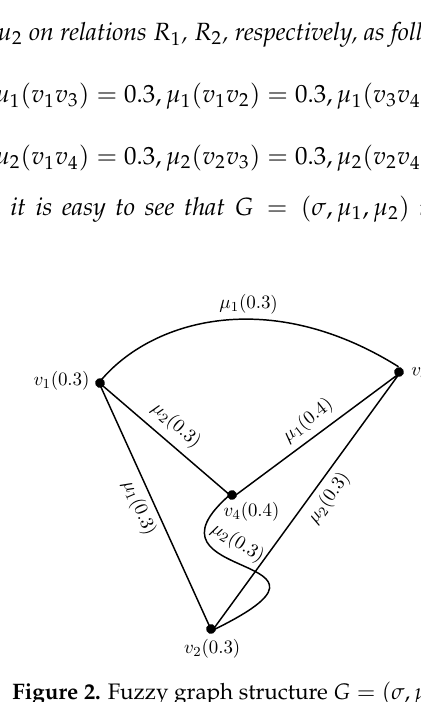
R 2 Figure 1: Graph Structure G ∗ = ( V, R 1 , R 2 ) In this graph structure each edge is labeled as R 1 or R 2 . 64